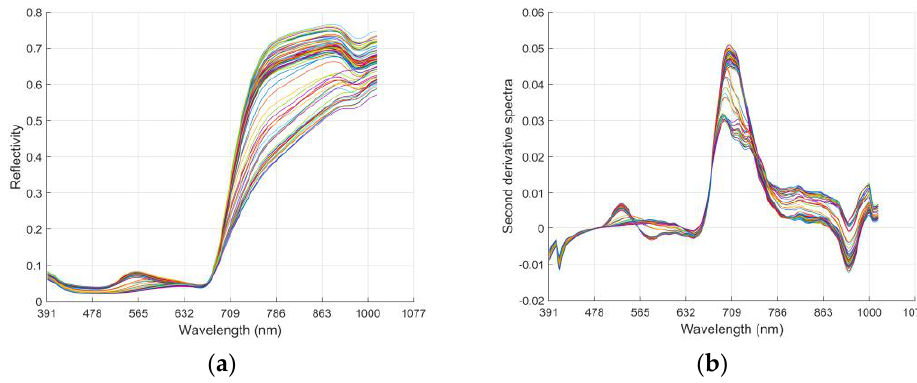
Figure 3. Raw data and spectra after pretreatment. ( a ) Original spectra of tea samples; ( b ) spectra after preprocessing by MSC + 1D + S-G algorithm schemes follow another format.